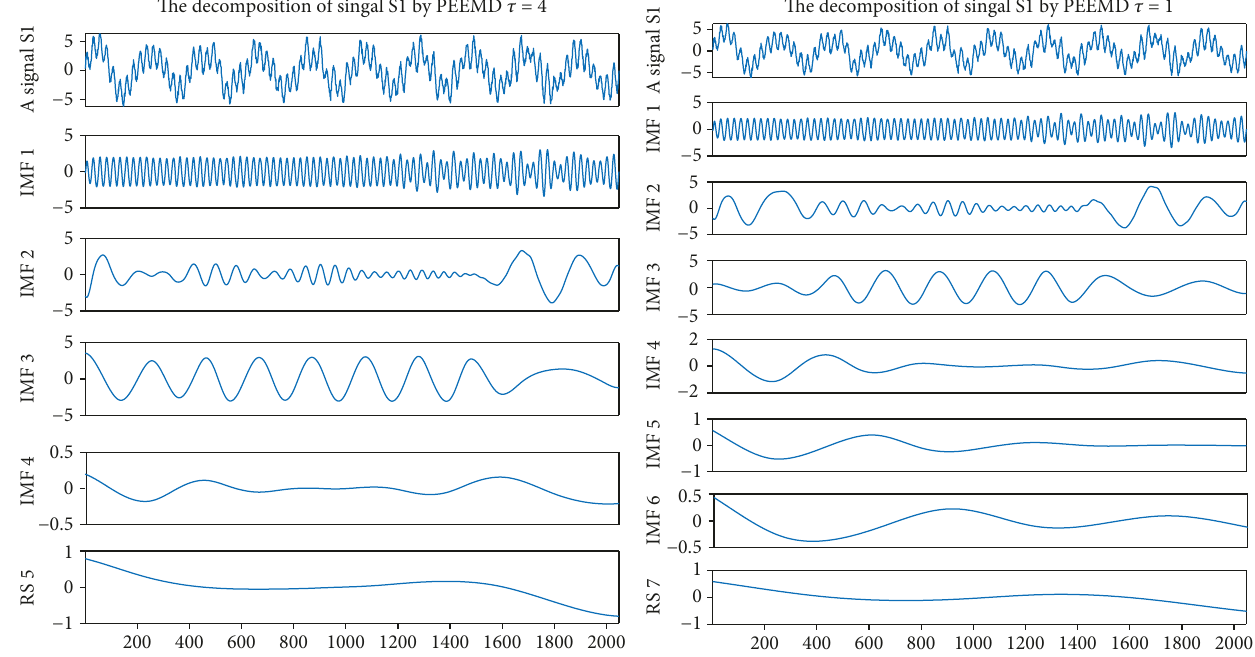
via the PEEMD method with τ = 4, 1 . 1